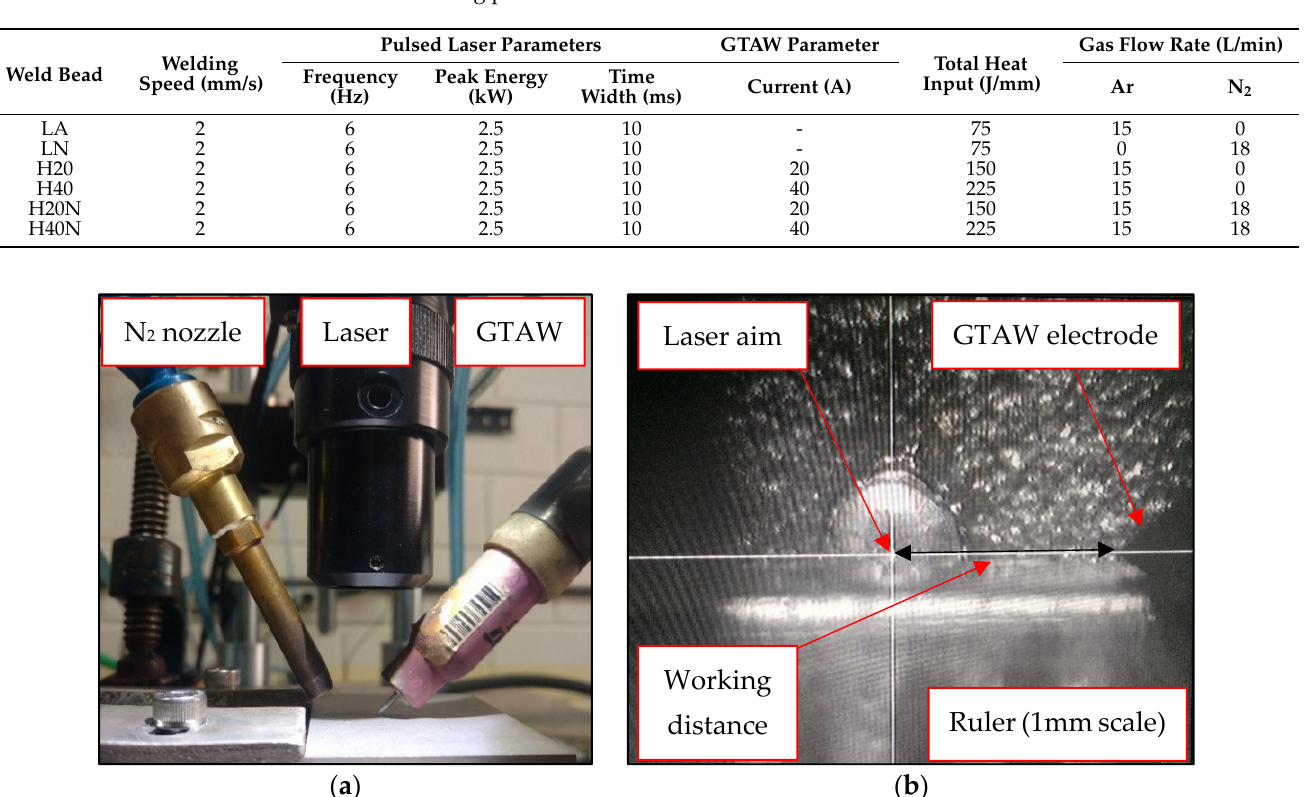
Table 2. Welding parameters.